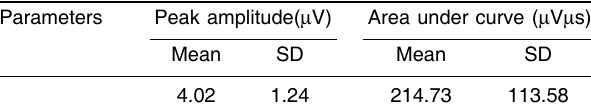
Table 2 The mean and SD of peak amplitude and area under